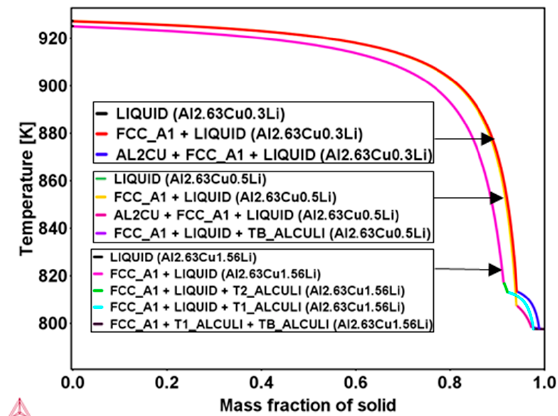
Figure 4. Scheil simulation using the database TTAl8 in Thermo-Calc software for three different Al-2.63Cu-xLi alloys, Li = 0.3 wt.%, 0.5 wt.%, and 1.56 wt.%, showing the solidification path, primary